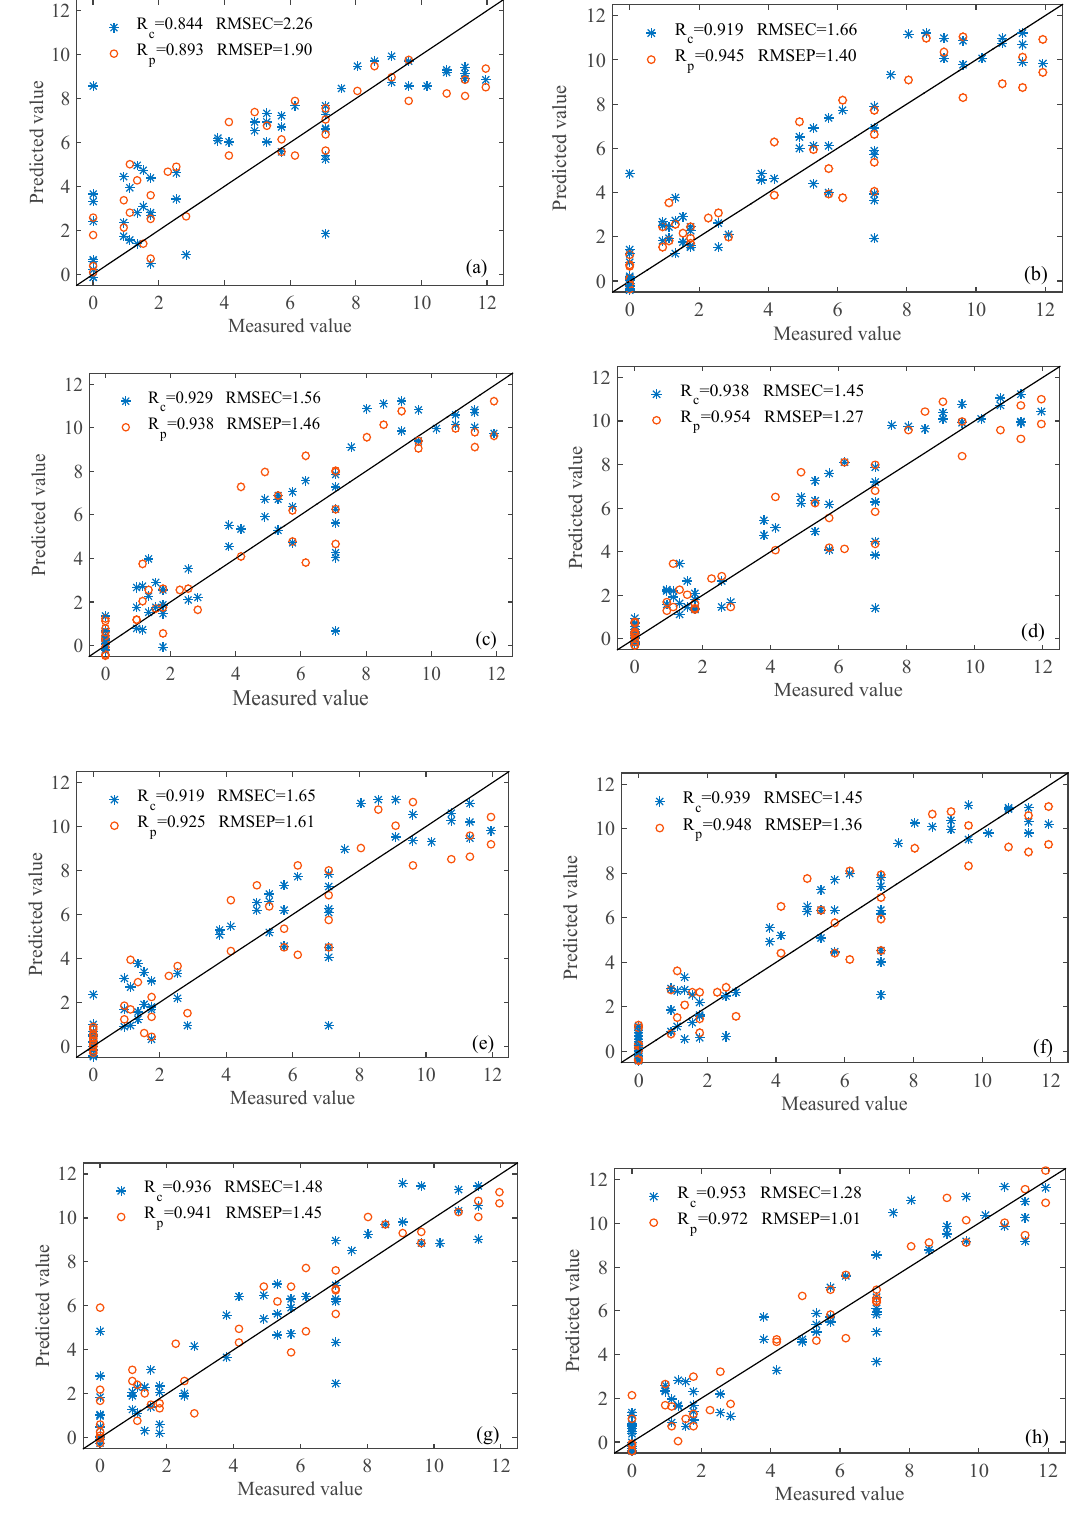
Figure 6. ( a , b ) Quantitative model results for all sensor versus characteristic sensor information using PLS; ( c , d ) Si-PLS; ( e , f ) GA-PLS; ( g , h ) CARS-PLS.